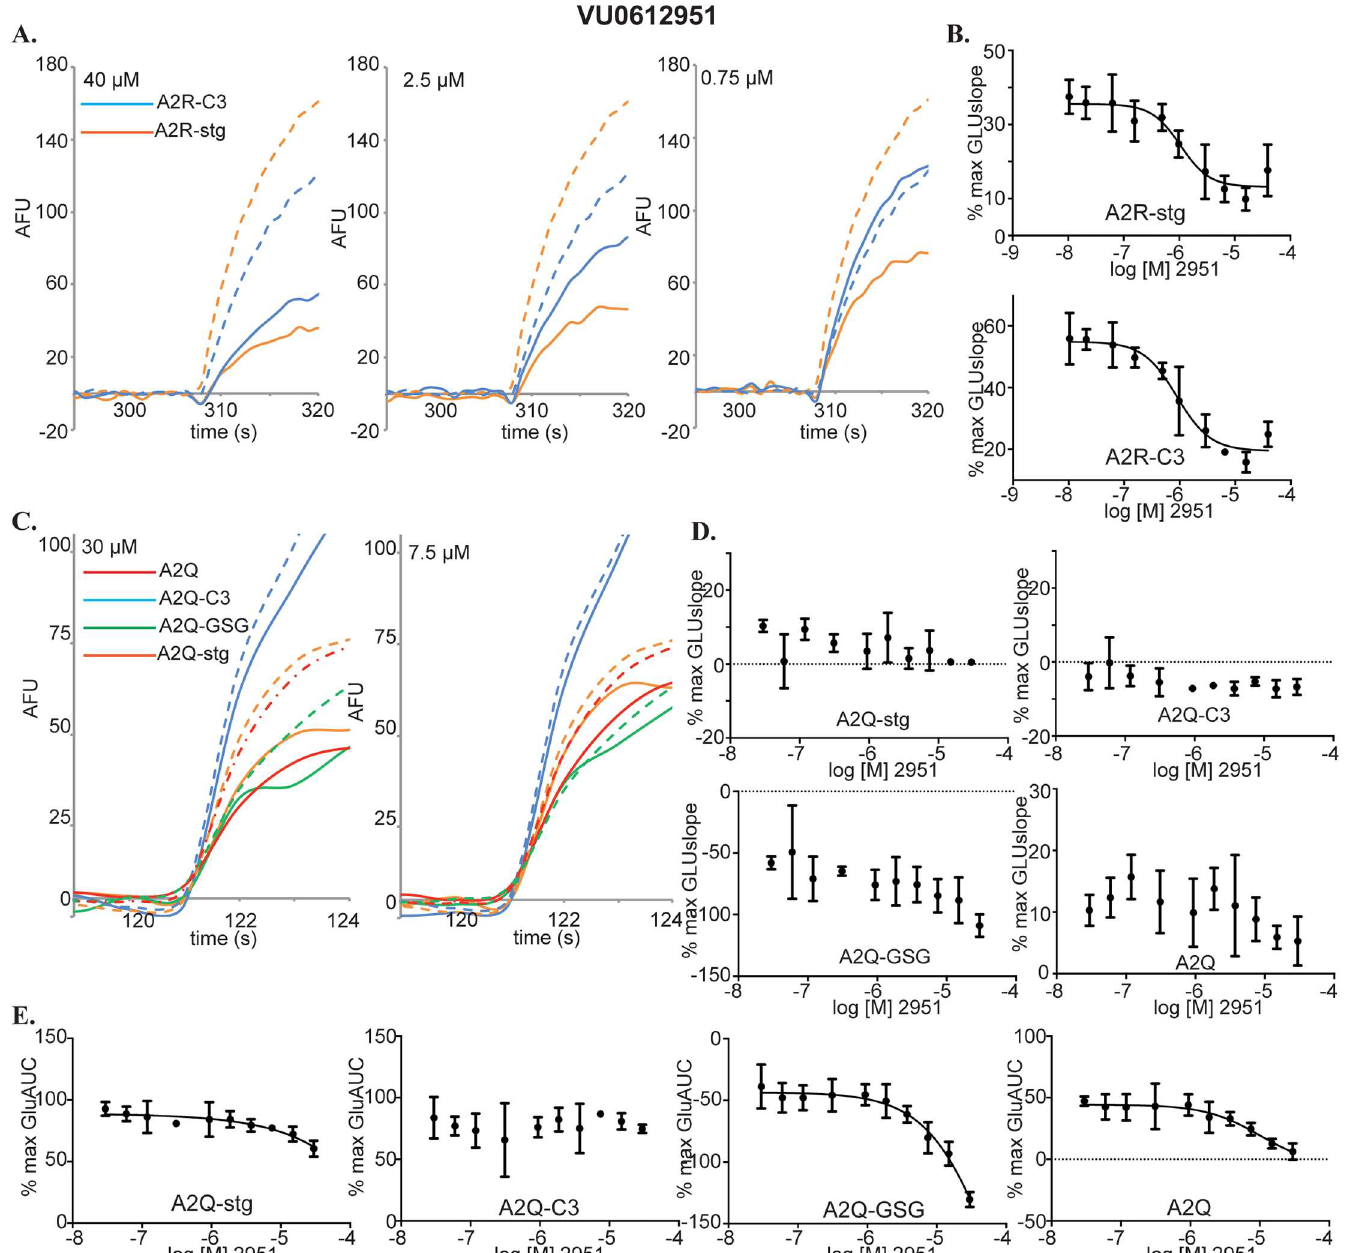
Fig 7. Characterization of VU0612951. (A) Raw data for compoundCRCs in the VSD assay. A2R-stg (orange)and A2R-C3 (blue). EC 50 GLU traces are representedby dashed lines. Compoundconcentrations are indicatedin the top left corner. (B) CRCs calculatedfrom GLUslopein the VSD assay for A2R- stg and A2R-C3 cells. Error bars are standard deviations. (C) Raw data for compoundCRCs in the calciumflux assay. A2Q (red), A2Q-stg (orange), A2Q-GSG (green), and A2Q-C3 (blue). Dashedlines are signalof 1mM glutamatewithout compound. (D) CompoundCRCs in calcium flux assay for A2Q- stg, A2Q-C3, A2Q-GSG, and A2Q cell lines. These are derivedfrom the GLUslope1 window. (E) CompoundCRCs calculatedfrom the AUC in the GLUmaxmin windowof the calcium flux assay plotted as %max AUC in the GLUmaxmin window(see Fig 4C) vs. log